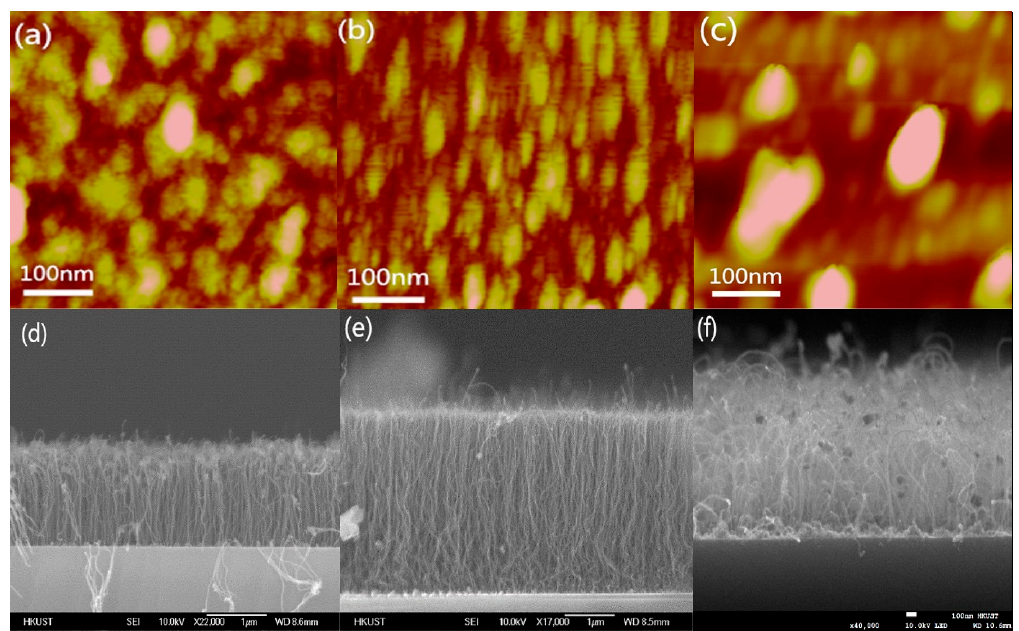
Figure 6. Atomic force microscopy (AFM) images (500 nm × 500 nm area) of the samples’ surface after annealing at 450 °C in N 2 and H 2 with ( a ) Ni (2 nm) catalyst, ( b ) Ni–Al–Ni (1 nm–0.5 nm–1 nm) multilayer catalyst, and ( c ) Ni–Al–Ni (1 nm-1 nm-1 nm) multilayer catalyst; and SEM images of vertically-aligned CNTs grown at 450 °C with ( d ) Ni (2 nm) catalyst, ( e ) Ni–Al–Ni (1 nm–0.5 nm–1